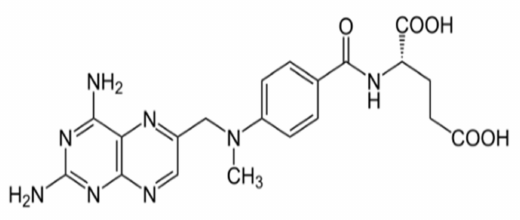
Figure 1. Structure of